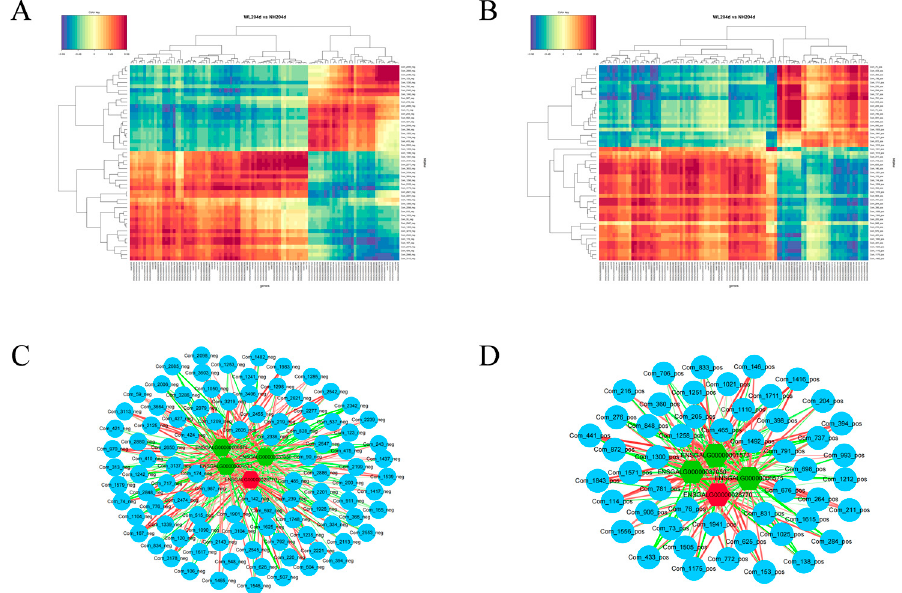
Figure 6. Correlation heat maps and network plots of DEGs and SDMs. ( A ) Heat map of the corre- lation between significantly differential genes and significantly differential metabolites in the nega- tive model; ( B ) Heat map of the correlation between significantly differential genes and significantly differential metabolites in the positive model; ( C ) Correlation network diagram in the negative model; ( D ) Correlation network diagram in the positive model. Circles indicate differential metab- olites, hexagons indicate differential genes, red indicates up-regulated genes, green indicates down- regulated genes, red lines indicate positive correlations, green lines indicate negative correlations and the thickness of the line indicates the strength of the correlation.